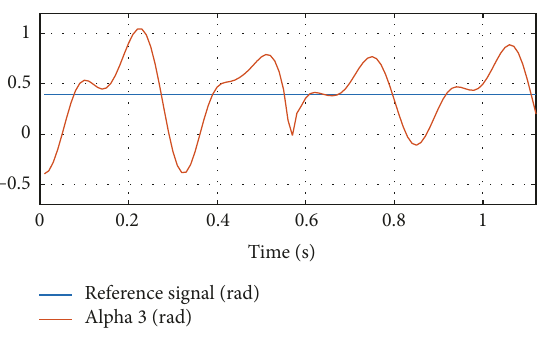
Figure 22: Trajectory of 𝛼 3 (rad).